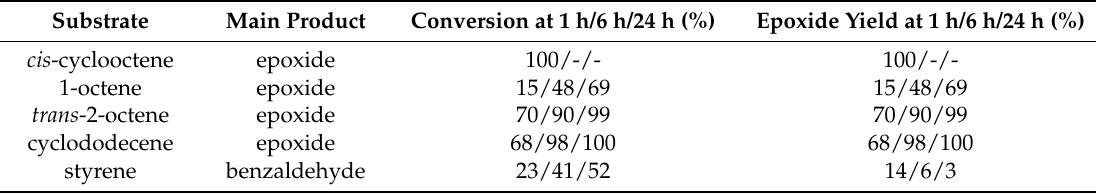
Table 2. Catalytic epoxidation of olefins with TBHP, in the presence of 1 OD 1 . Substrate Main Product Conversion at 1 h/6 h/24 h (%) Epoxide Yield at 1 h/6 h/24 h (%) cis -cyclooctene epoxide